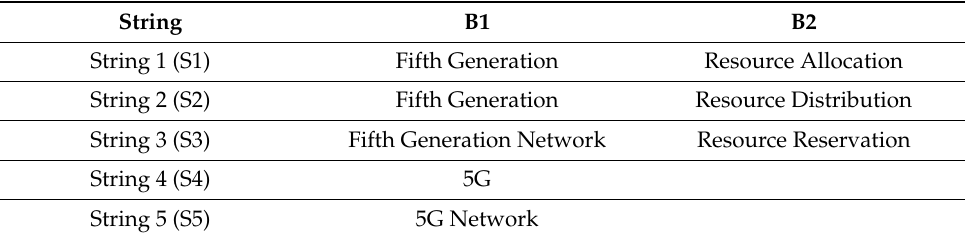
Table 1. List of Keywords and